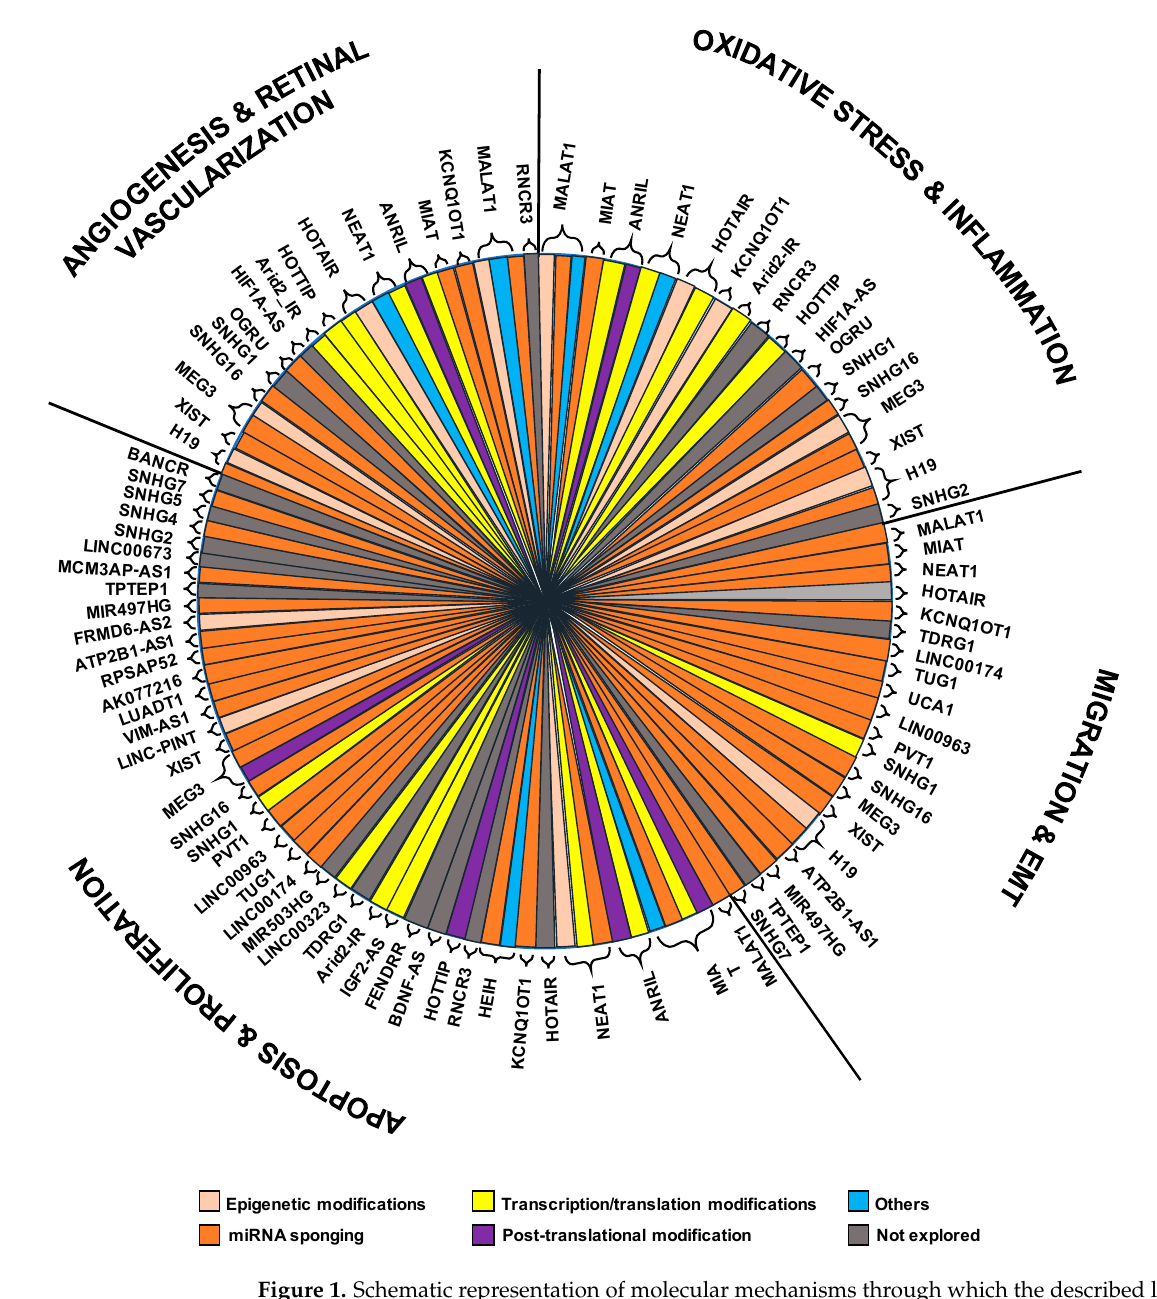
Epigenetic modifications miRNA sponging Figure 1. Schematic representation of molecular mechanisms through which the described lncRNAs exert their functions in different pathways/processes related to diabetic retinopathy.